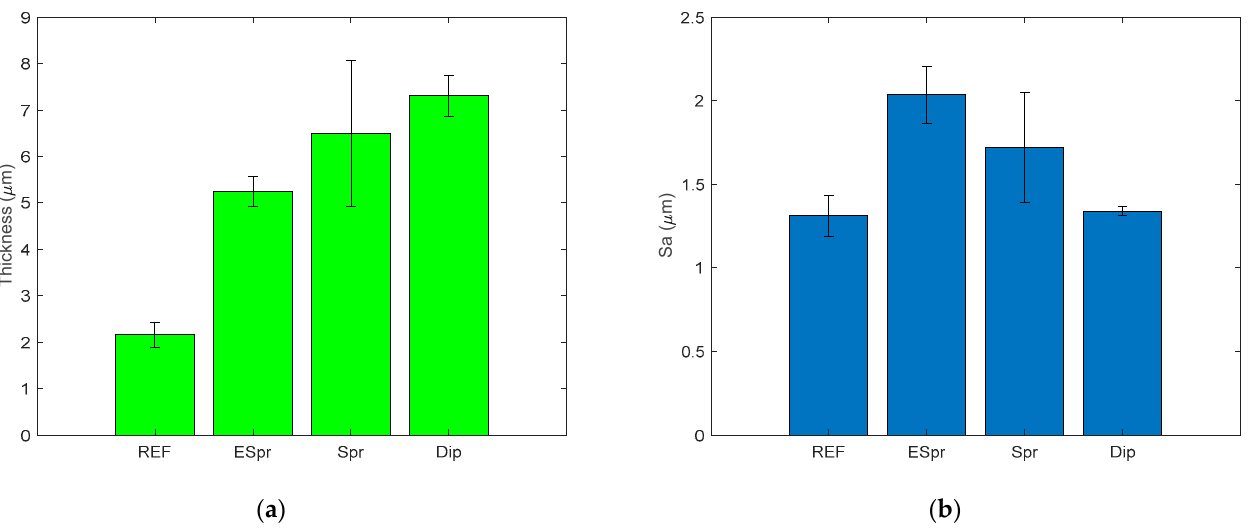
Figure 4. Roughness and thickness results of the analyzed functional coatings: ( a ) Thickness bar graph of the Ref, ESpr, Spr, and Dip samples with their corresponding value of standard deviation; ( b ) Roughness bar graph of the Ref, ESpr, Spr, and Dip samples with their corresponding value of standard deviation.